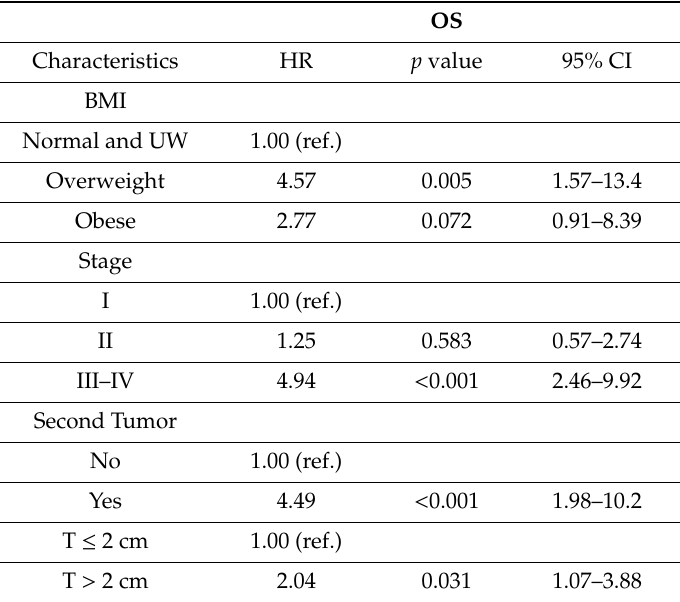
Table 3. Multivariate Analysis HR (95% CI) of